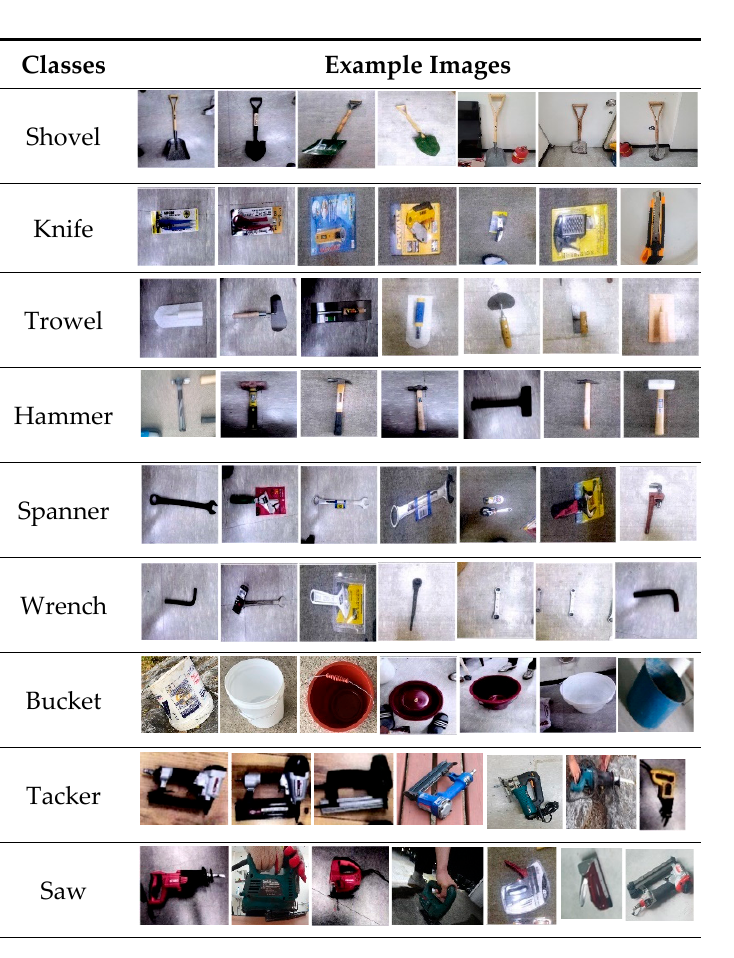
Table 1. YOLOv5 models results on small and medium-sized construction tools [9]. (Reproduced with permission from Lee et al., KSCE Journal of Civil Engineering; published by Korean Society of Civil Engineers, 2023)